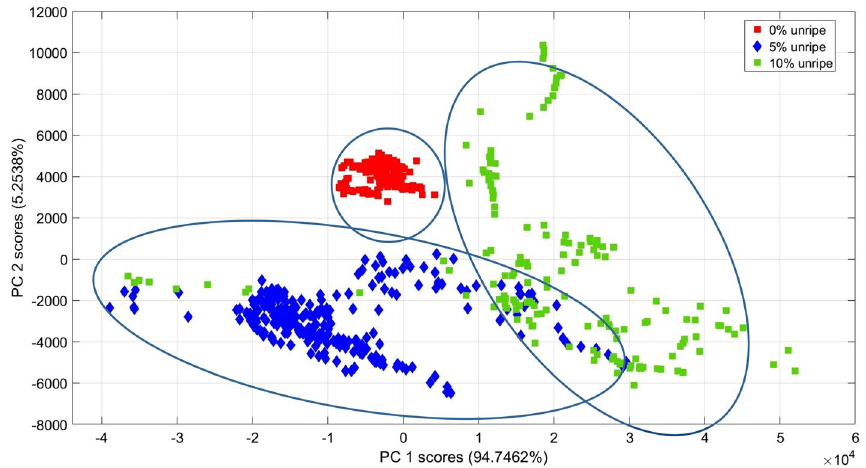
Figure 8. PCA scattered plot between PC1 and PC2 of chlorophyll fluorescence spectra from DCO extracted from 0% unripe (red), 5% unripe (blue) and 10% unripe (green) FFB.